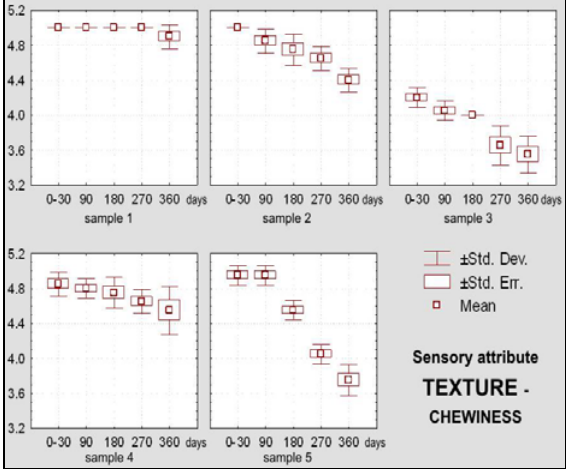
Figure 13 . Box-plots for sensory attribute texture – chewiness of dietary chocolate.